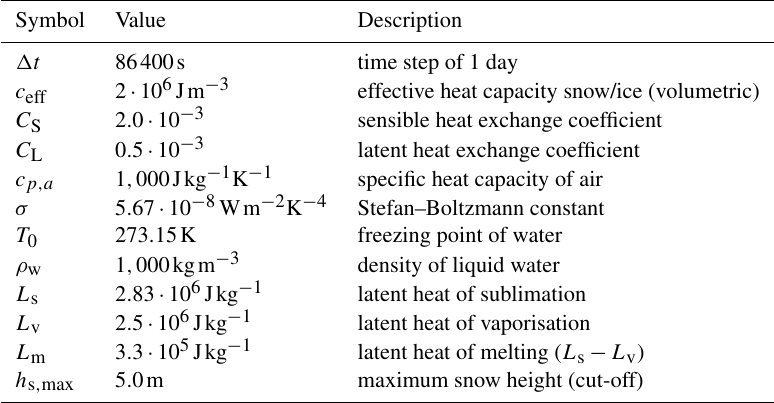
Table 1. Model constants and their description.